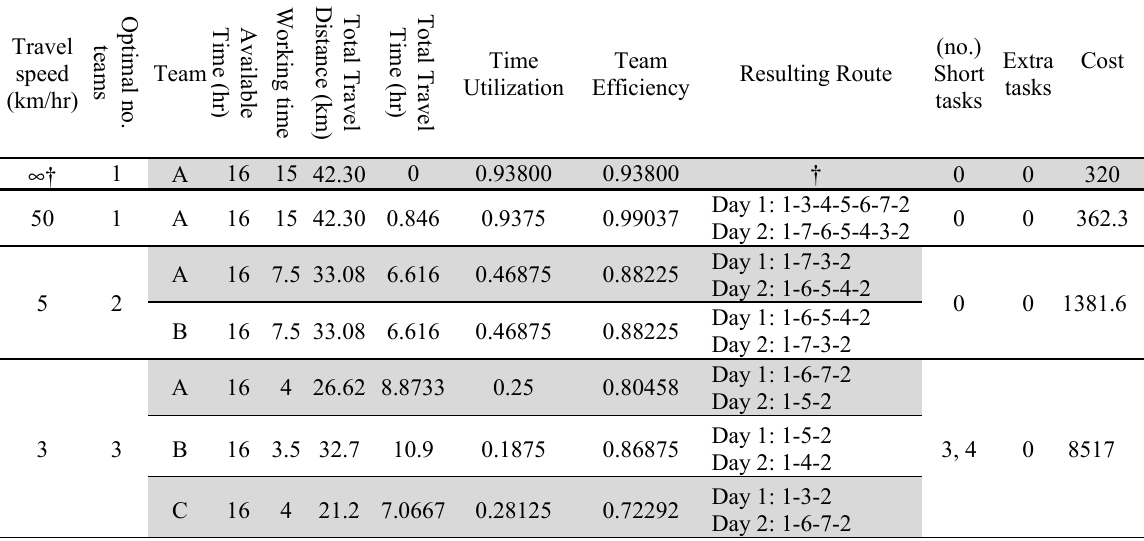
Results of first instance (5 tasks, 1-3 teams, and 2 days).